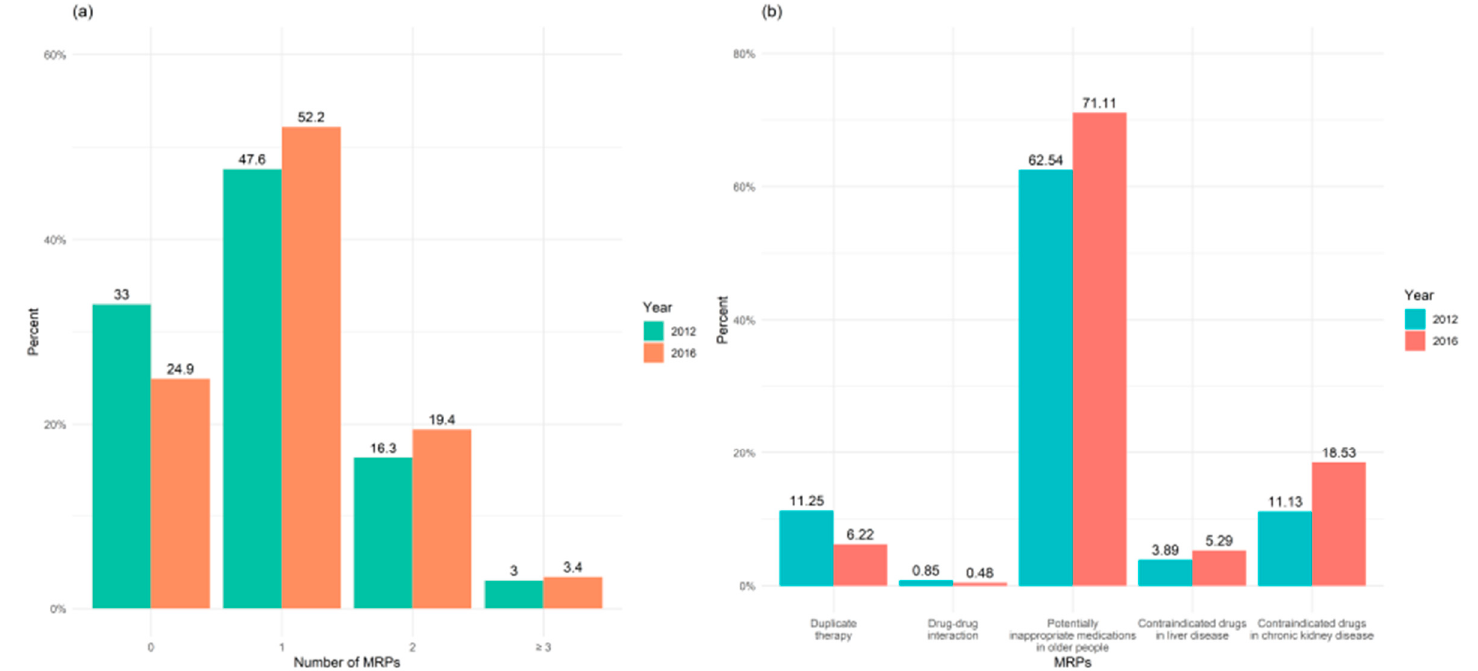
Figure 2. ( a ) Frequencies and ( b ) types of medication-related problems (MRPs) in older people with multimorbidity at baseline (2012) and at end of study (2016) (N = 723,016). Table 1. Descriptive characteristics of older people by multimorbidity groups at baseline and at the end of the study (N = 723,016).